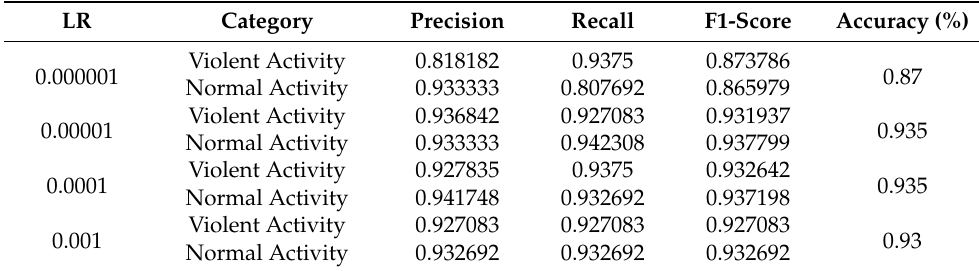
Table 9. Detail summary of the second experiment. A bidirectional LSTM was used to learn the complex pattern of violent activity effectively.